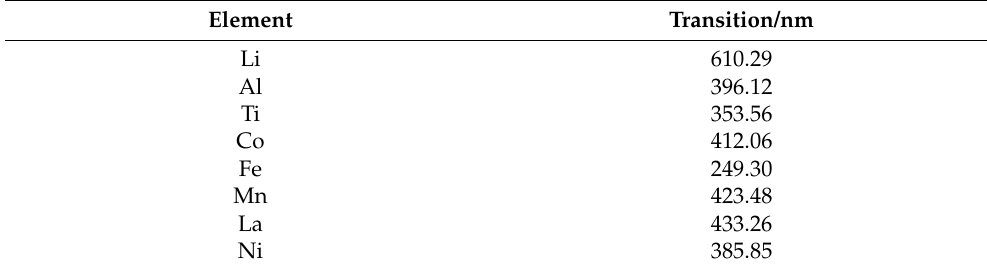
Table 5. Selected transition lines of different battery